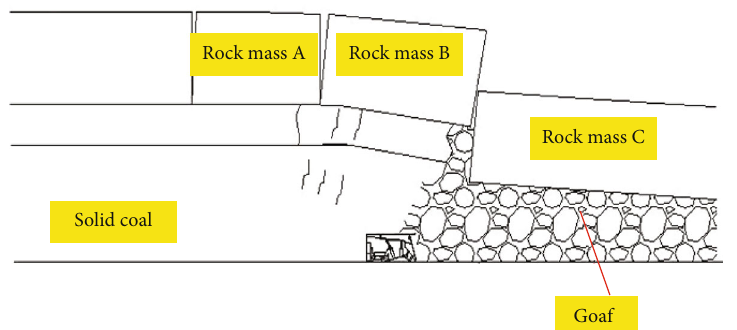
Figure 4: “ Sidestepped rock beam ” structural model.